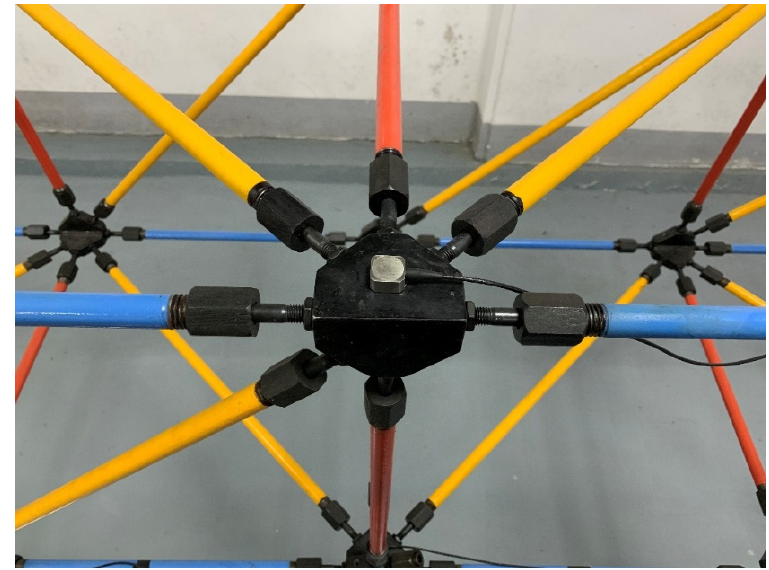
Figure 2. Details of a typical joint with the attached acceleration sensor.